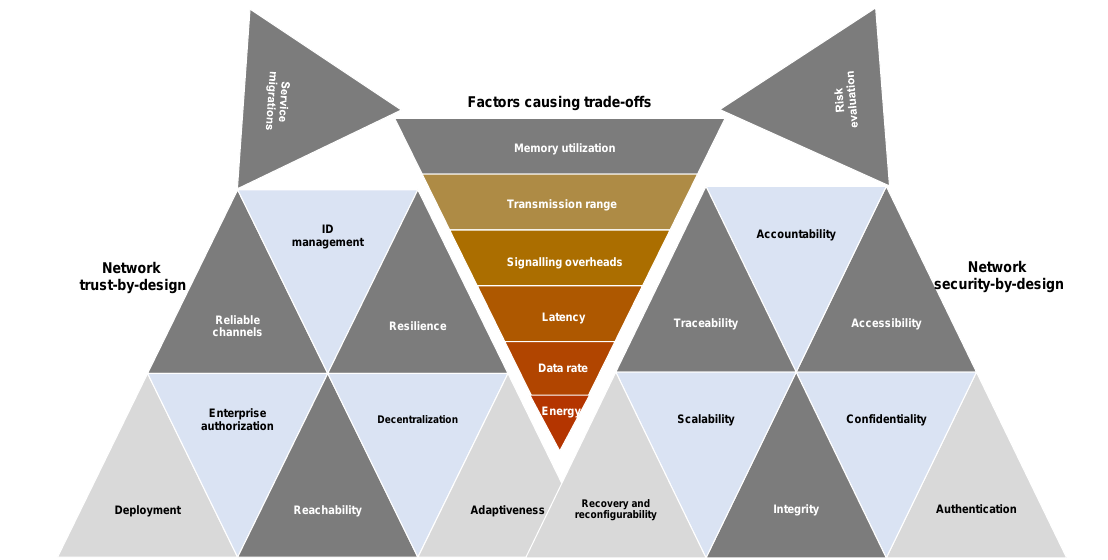
Figure 3. Principles of security-by-design and trust-by-design with associated performance trade-offs for 6G